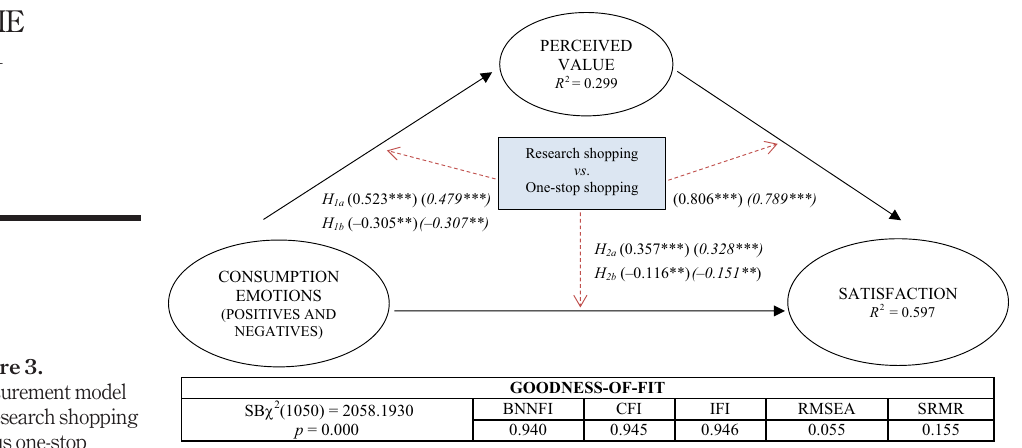
Figure 3. Measurement model for research shopping versus one-stop shopping